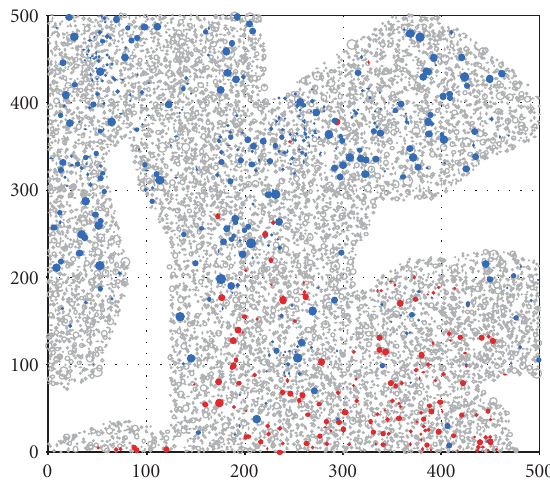
Figure 8: Map of trees. Vouacapoua americana trees are blue, Qualea rosea red and other trees grey. Circle sizes are proportional to those of the trees. Flooded zones are excluded. Distances are in meters.